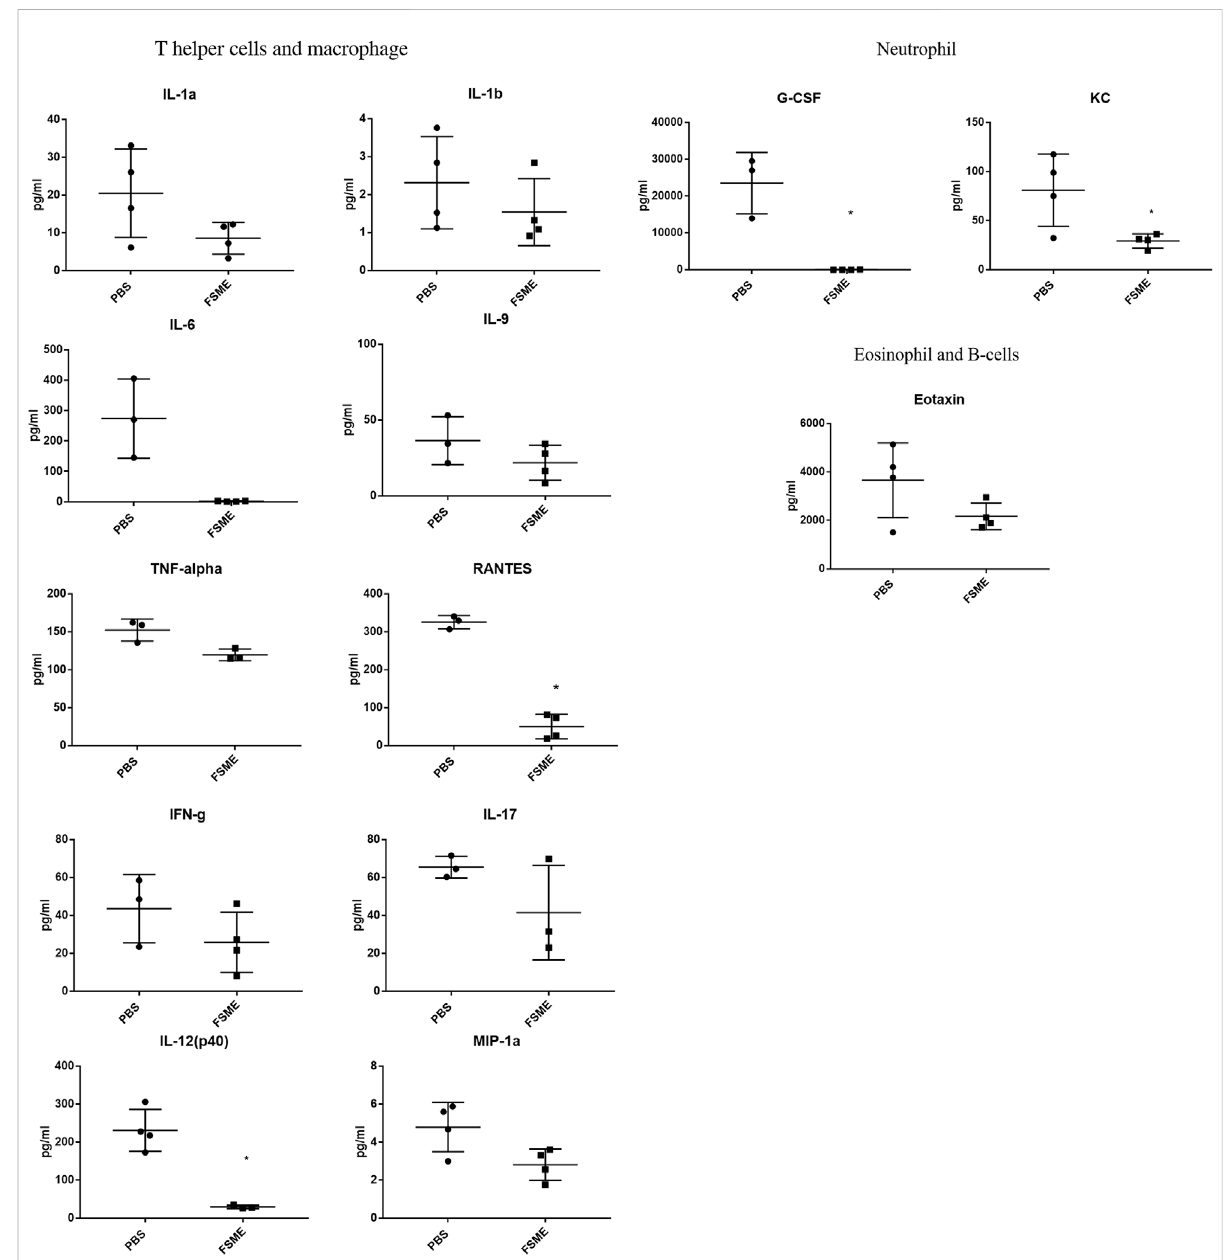
FIGURE 7 Multiplex analysis of serum in fl ammatory cytokines in 20-month-old mice after FSME (30 mg/kg) treatment for 8 weeks. Serum in fl ammatory cytokines showed no signi fi cant up-regulation in in fl ammatory cytokines after FSME administration in 20-month-old mice and pro-in fl ammatory cytokines, IL-12 (p40), RANTES, KC, and G-CSF show signi fi cant down-regulation after FSME treatment in 20-month-old mice. * represents p < 0.05 by the non-parametric Mann – Whitney test method. N = 4; results are presented as mean ±